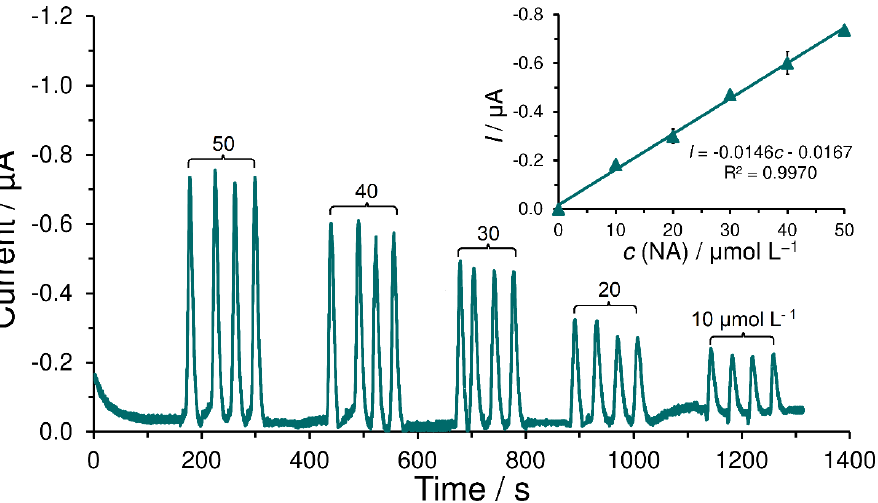
Figure 8. Typical amperogram of calibration measurement of noradrenaline (NA) obtained at SPCE/P4HB-TYR-GTA in an FIA arrangement. Supporting electrolyte: 0.1 mol L −1 PB (pH 7.0, not deaerated), detection potential; −0.2 V, injection volume; 100 μL, flow rate; 1.0 mL min −1 , and laboratory temperature; 25 °C.